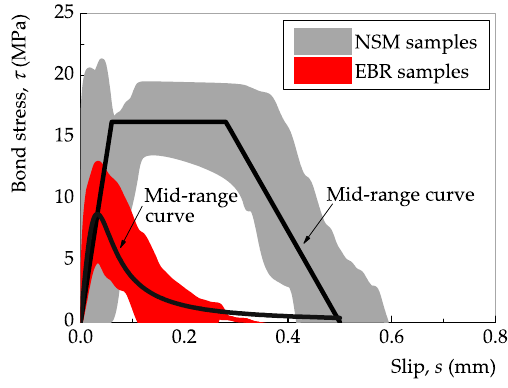
Fig. 15 Comparison between bond–slip